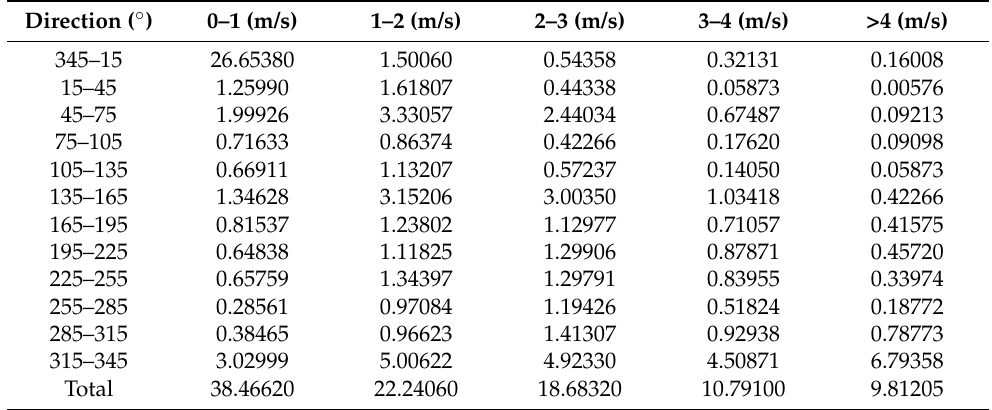
Figure 5. Wind direction and speed at the aerospace facility in Goheung (Korea Meteorological Administration). Table 4. Probability of jet fire, according to wind direction and speed.